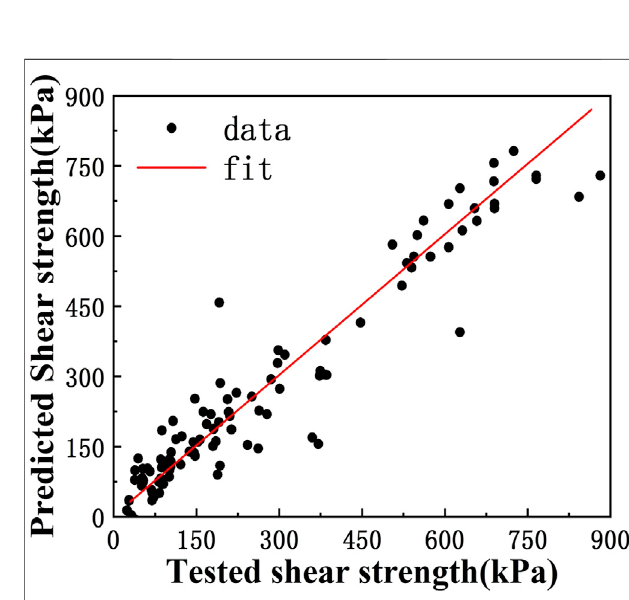
FIGURE 12 | Results of the leave-one-out cross validation of the BP neural